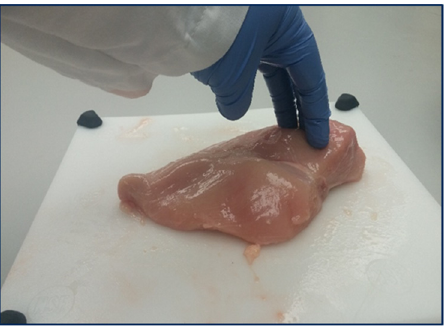
Figure 1. Hand palpation of fillets for manual classification based on severity level.